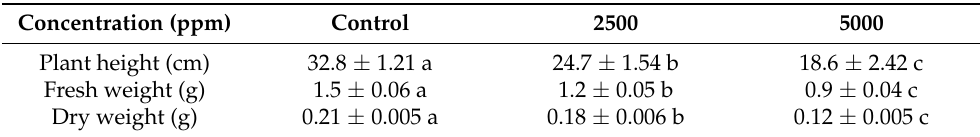
Table 3. Effect of SCE treatment on the growth of Festuca arundinacea . Concentration